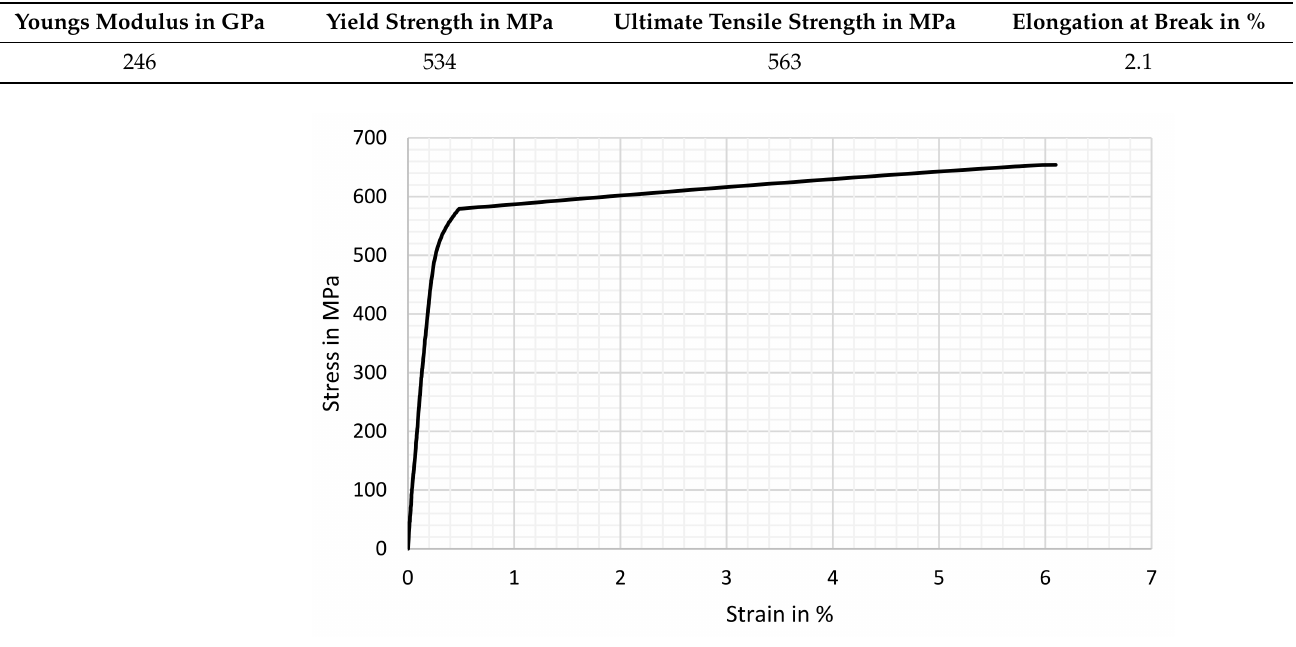
Table 4. Mechanical properties of the complex concentrated alloy (wall structure).